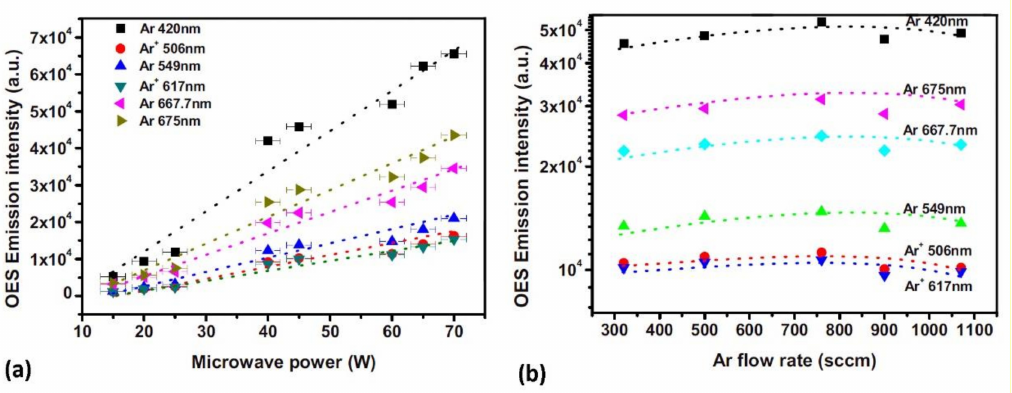
Figure 9. Influence of: ( a ) microwave power and ( b ) gas flow rate on the emission intensities of Ar spectral features. Reprinted with permission from [42] (Jia et al.). Copyright 2021 American Institute of